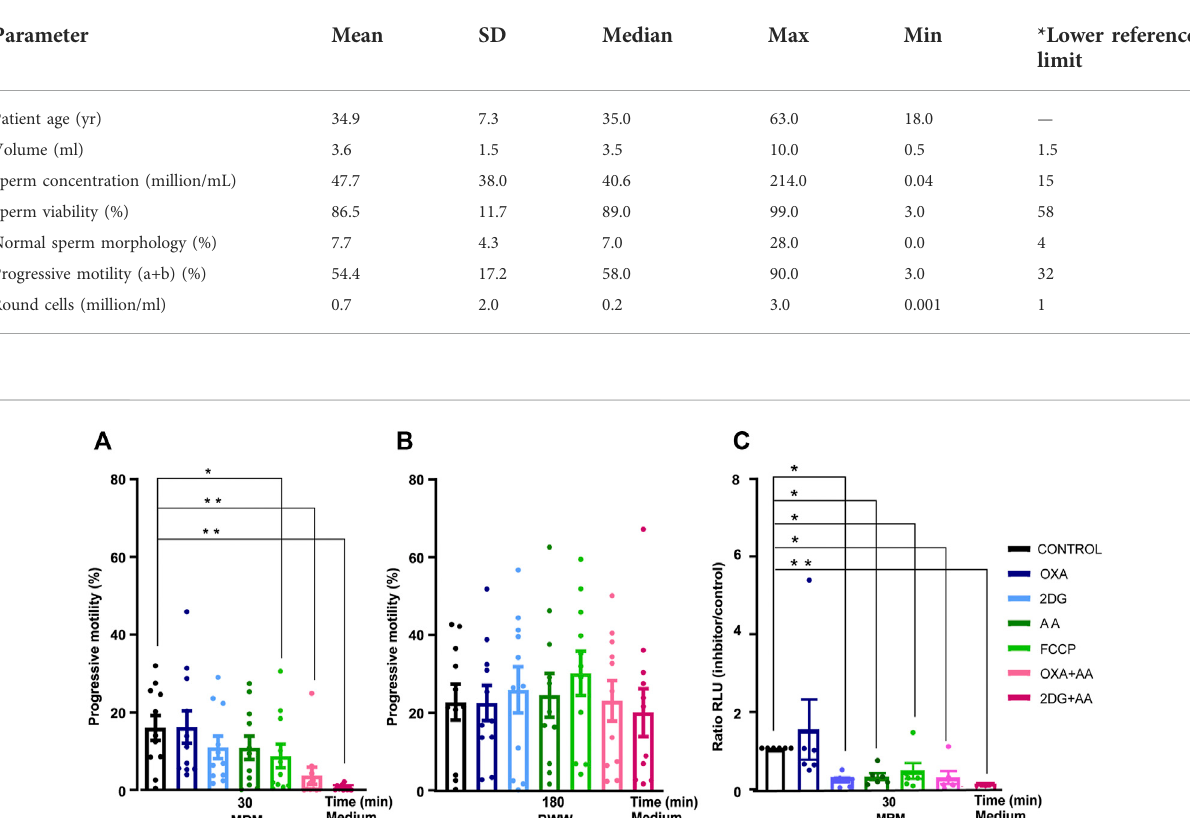
FIGURE 1 Changes in sperm motility and ATP production of human sperm incubated with metabolic inhibitors. Evaluation of the effects of glycolysis inhibitors and mitochondrial agents. (A) Progressive motility in presence of inhibitor and control at time = 30 min in MRM ( N = 11) (B) time = 180 min inBWW( N =11); (C) ATPproductionat30 mininMRMmedium( N =6).Barsrepresentmeans±SEM.Statisticalsigni fi cancebetweenthecontroland thedifferentgroupswasassessedwithaANOVA,Dunnett ’ smultiplecomparisonpairedtest* p < 0.05** p <